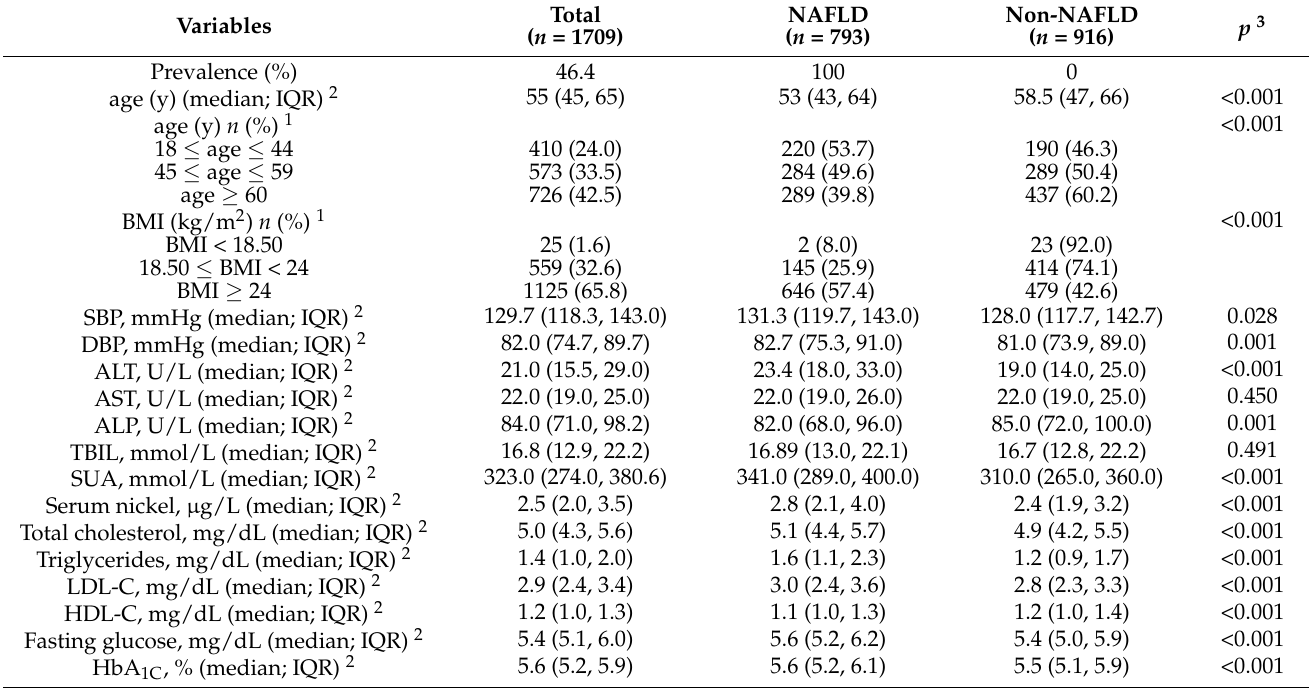
Table 1. The baseline